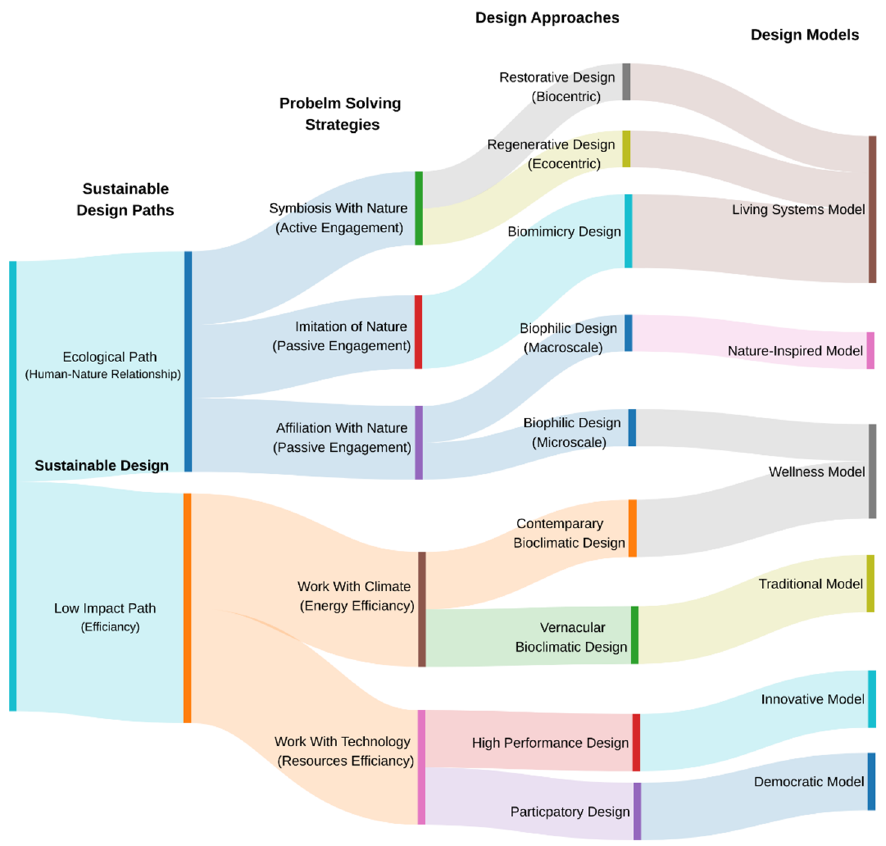
Figure 5. The developed schema for viable sustainable design models based on the findings of the first phase/step 1 of the study.